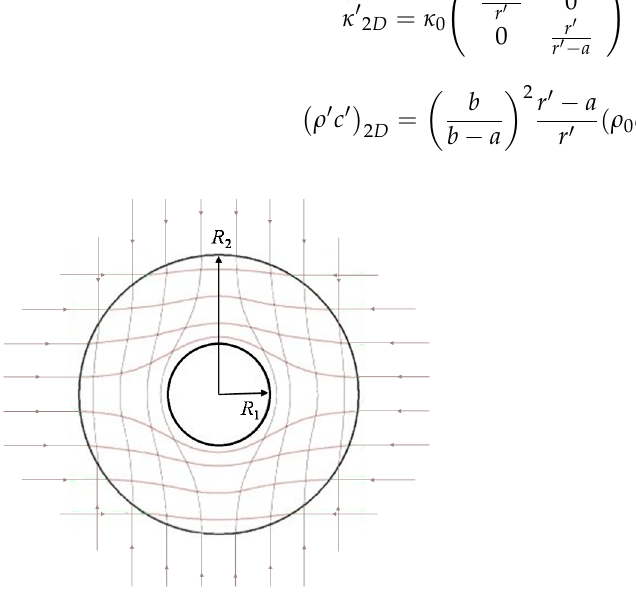
Figure 1. Sketch map of the transformed metric of an invisibility